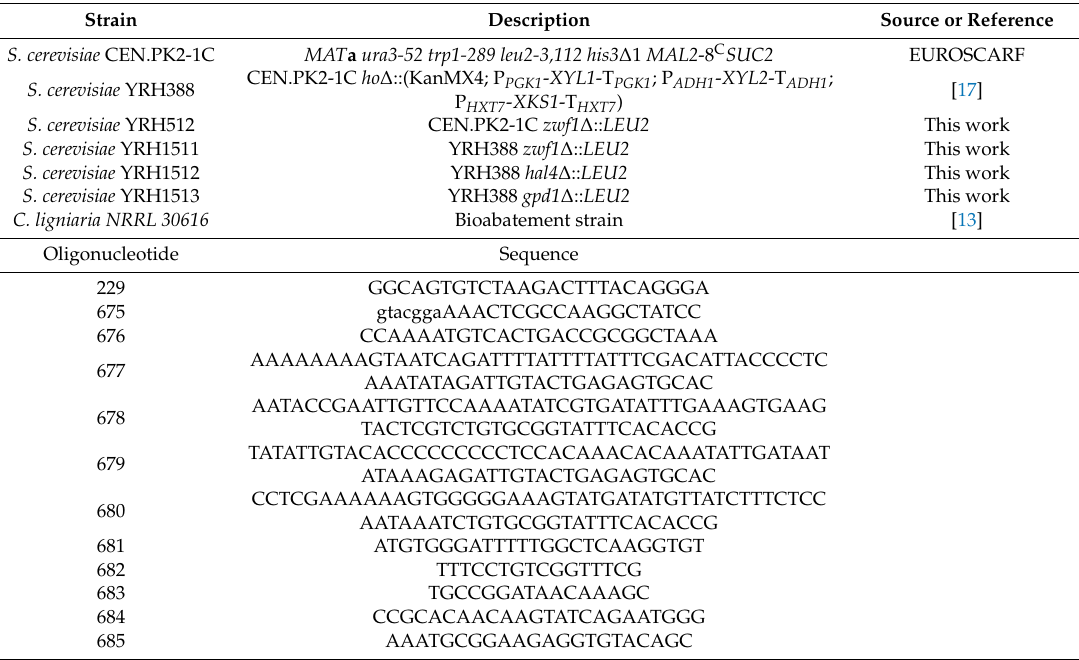
Table 1. Strains and oligonucleotides used in this